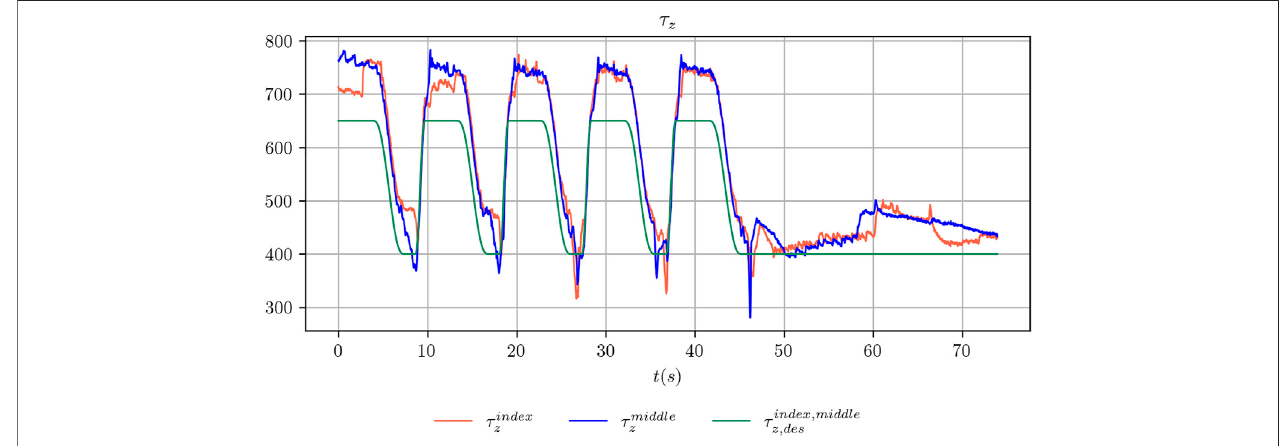
FIGURE3 | Comparison between thedesired grasp strength and theachieved grasp strength for theindex and middle fi ngers during the execution of acontrolled sliding experiment.